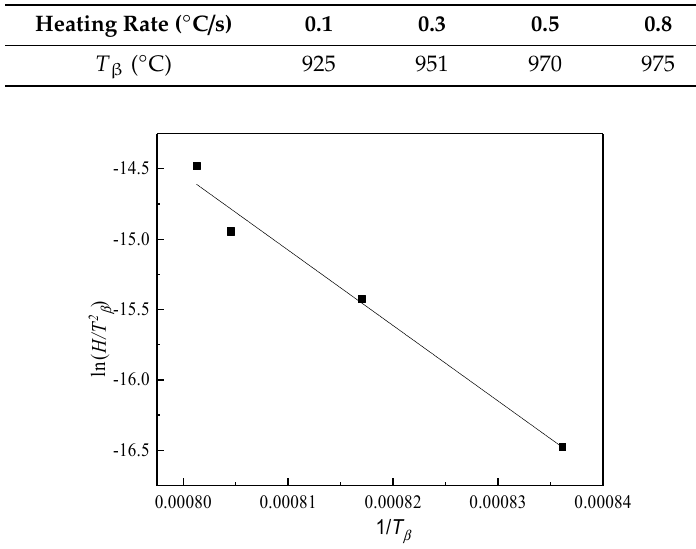
Table 2. The temperature corresponding to the maximum transformation rate at different heating rates.